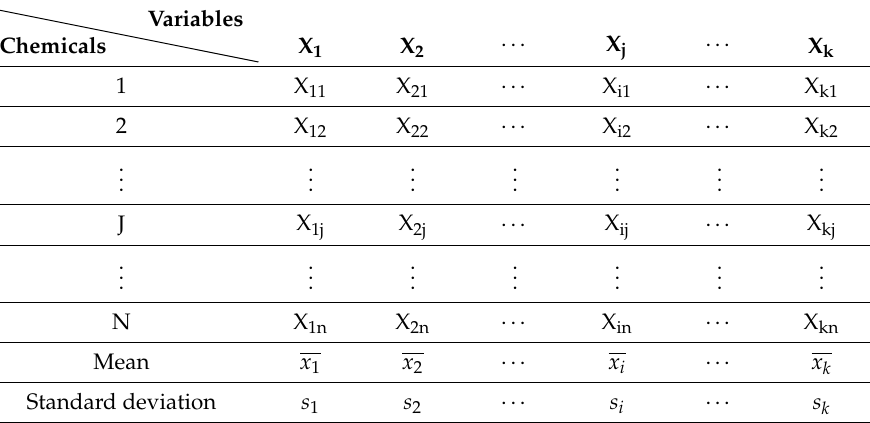
Table 1. Raw data of normal